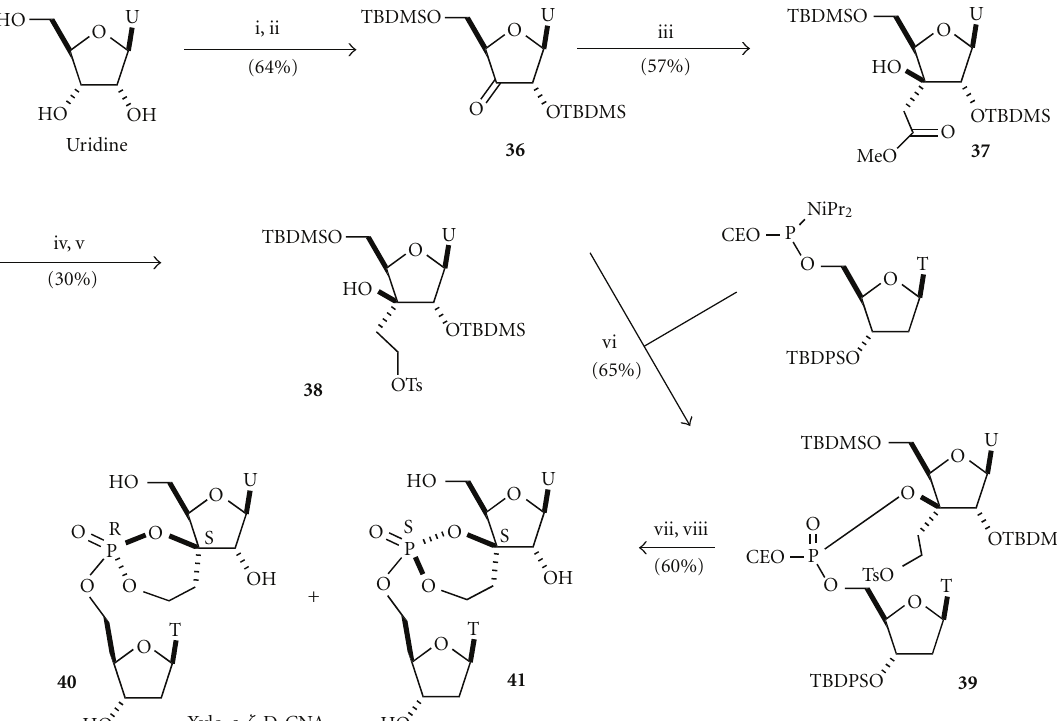
Scheme 6: Synthesis of xylo - ε , ζ -Dioxaphosphorinane-Constrained Nucleic Acid dinucleotides ( xylo - ε , ζ -D-CNA). Reagents and